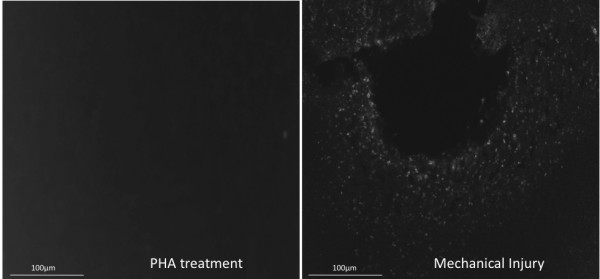
Representative sections black-white inverted following cell degeneration assay (TUNEL). TUNEL- labeled cells were not present in tissue exposed to PHA (A). PHA tissue was run concurrently with injured tissue to serve as a positive control (B).